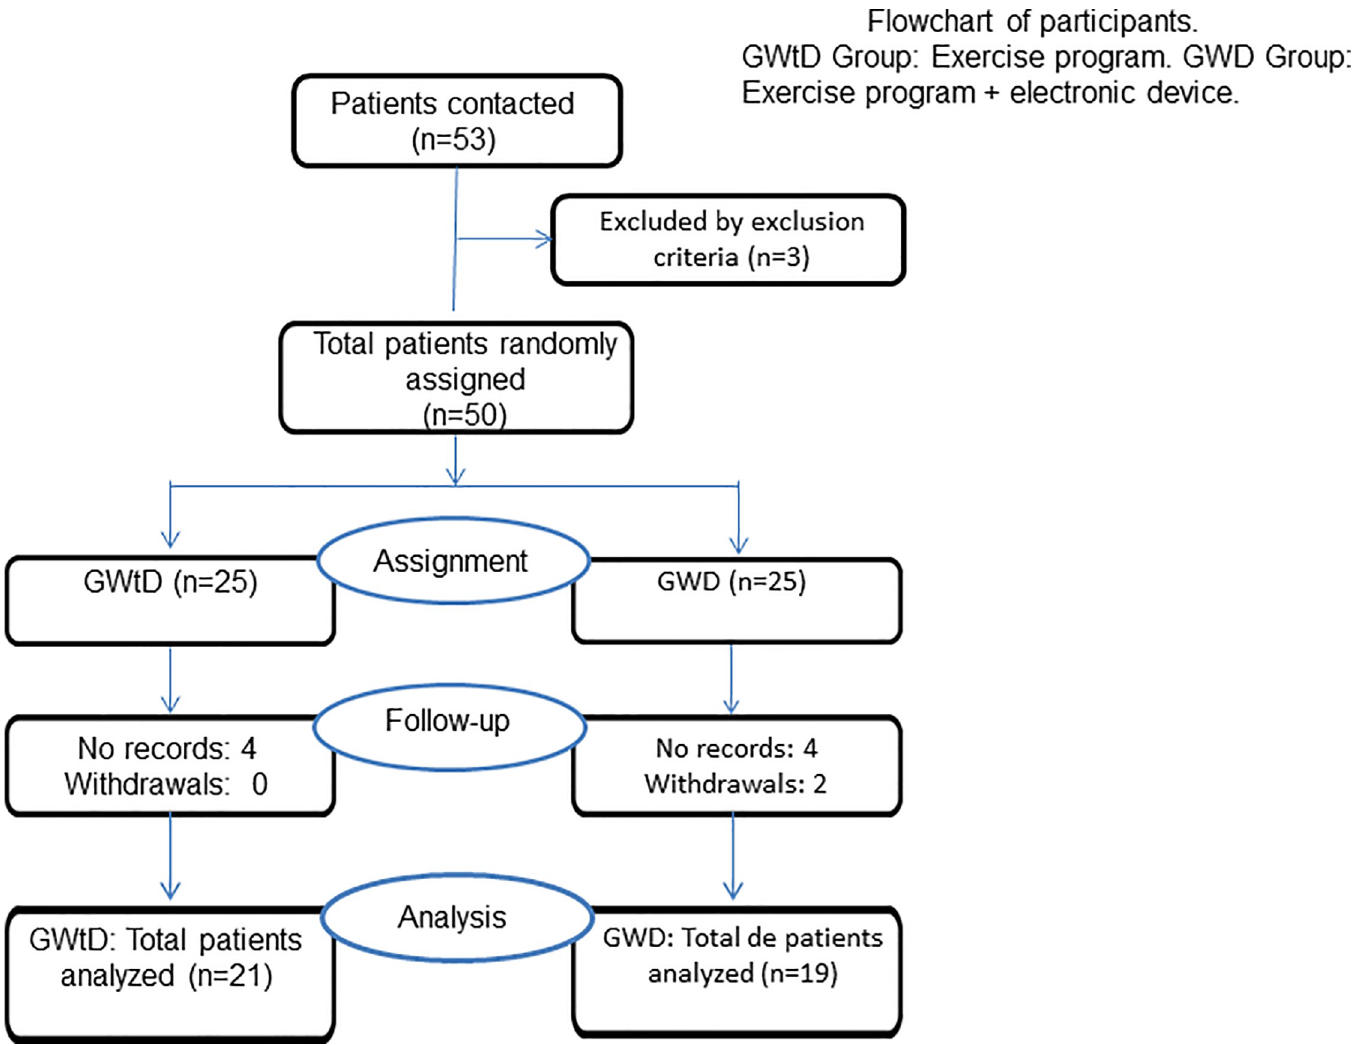
Fig 2. Flowchart of participants. GWtD Group: Exercise program. GWD Group: Exercise program + electronic device.